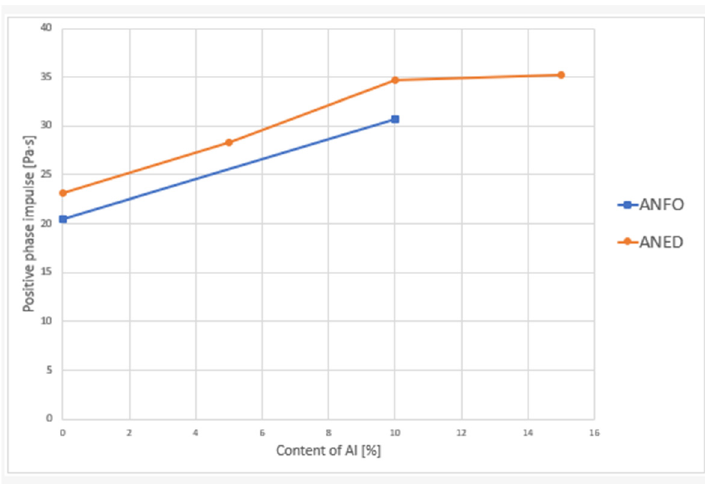
Figure 11. Dependences of specific impulse on the aluminium content in AN/fuel mixtures with the addition of aluminium at a distance of 2 m from the load.